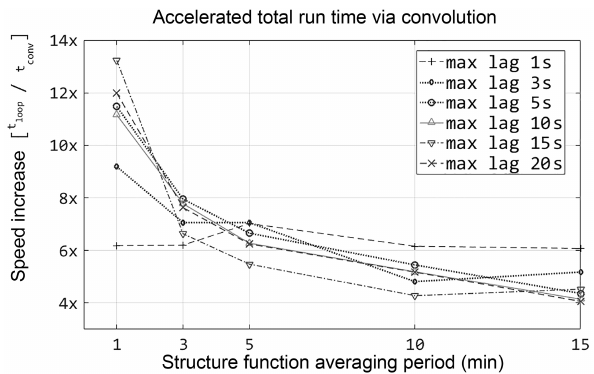
Figure 6. The performance gains using convolution are more signif- icant for short averaging periods, regardless of maximum lag used in calculating structure